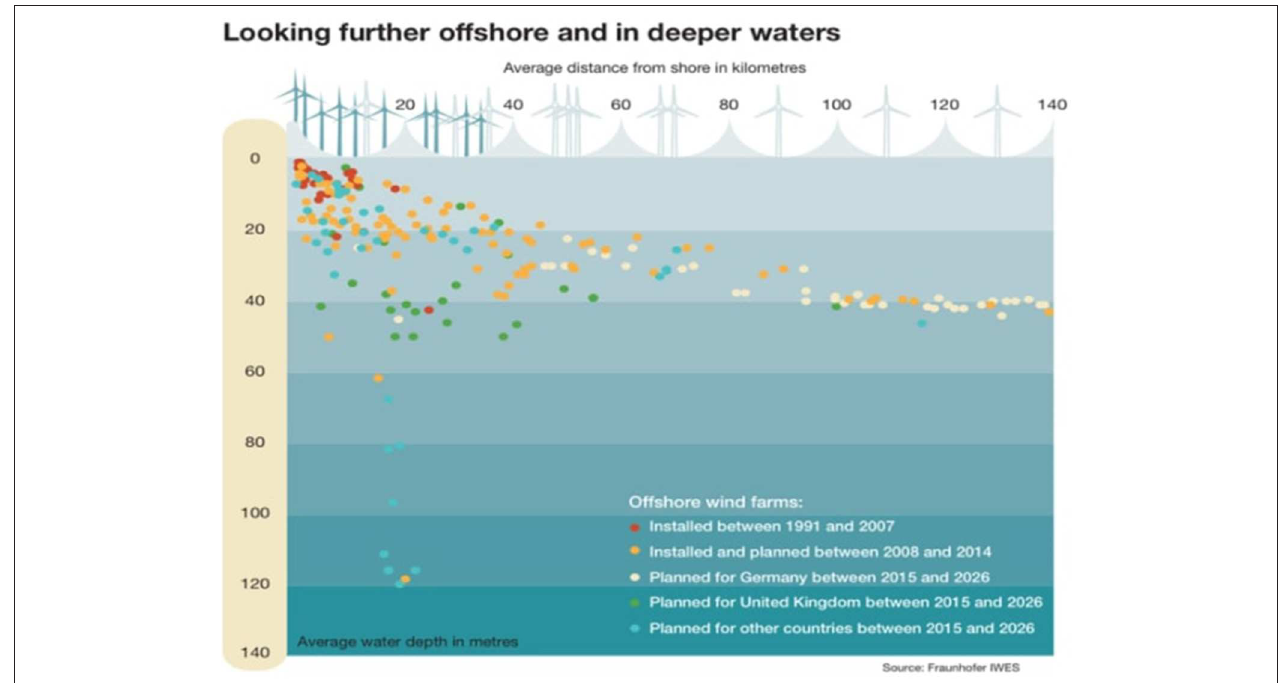
FIGURE 2 | WTG Foundation vs. water depth. Reproduced from Fraunhofer IWES and obtained in the following link of Grid-Arendal: http://old.grida.no/graphicslib/ OpenFile.aspx?id=09ffa8b4-86ca-4d5e-983f-42269b279226.